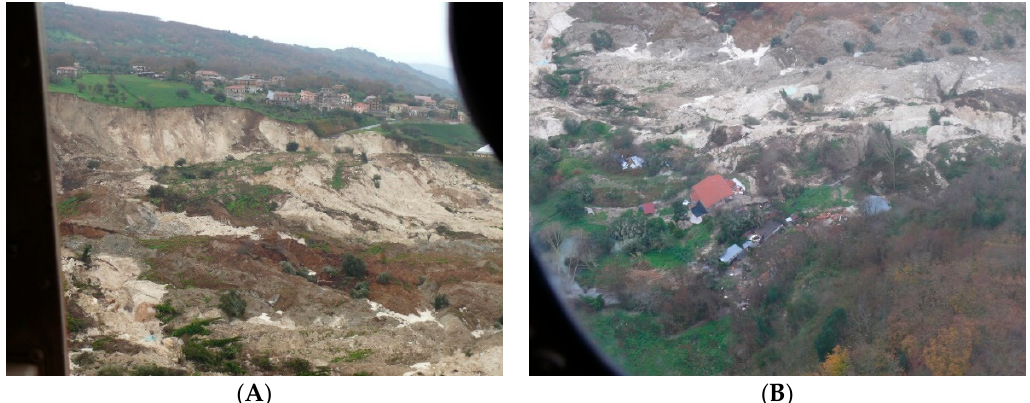
Figure 6. Examples of reconnaissance photographs taken from helicopter (on February 16, 2010), characterized by obstacles in the frame ( A ) or very oblique shot ( B ).